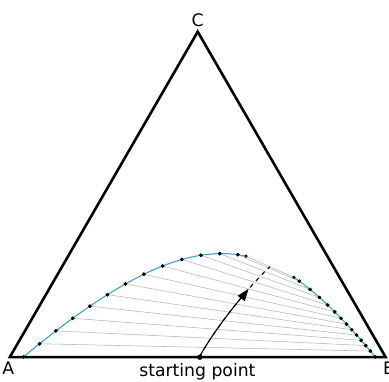
Figure 2. Sampling of the binodal curve: Trajectory of the feed composition at a constant phase ratio of 0.5 and corresponding equilibrium compositions on the binodal curve.